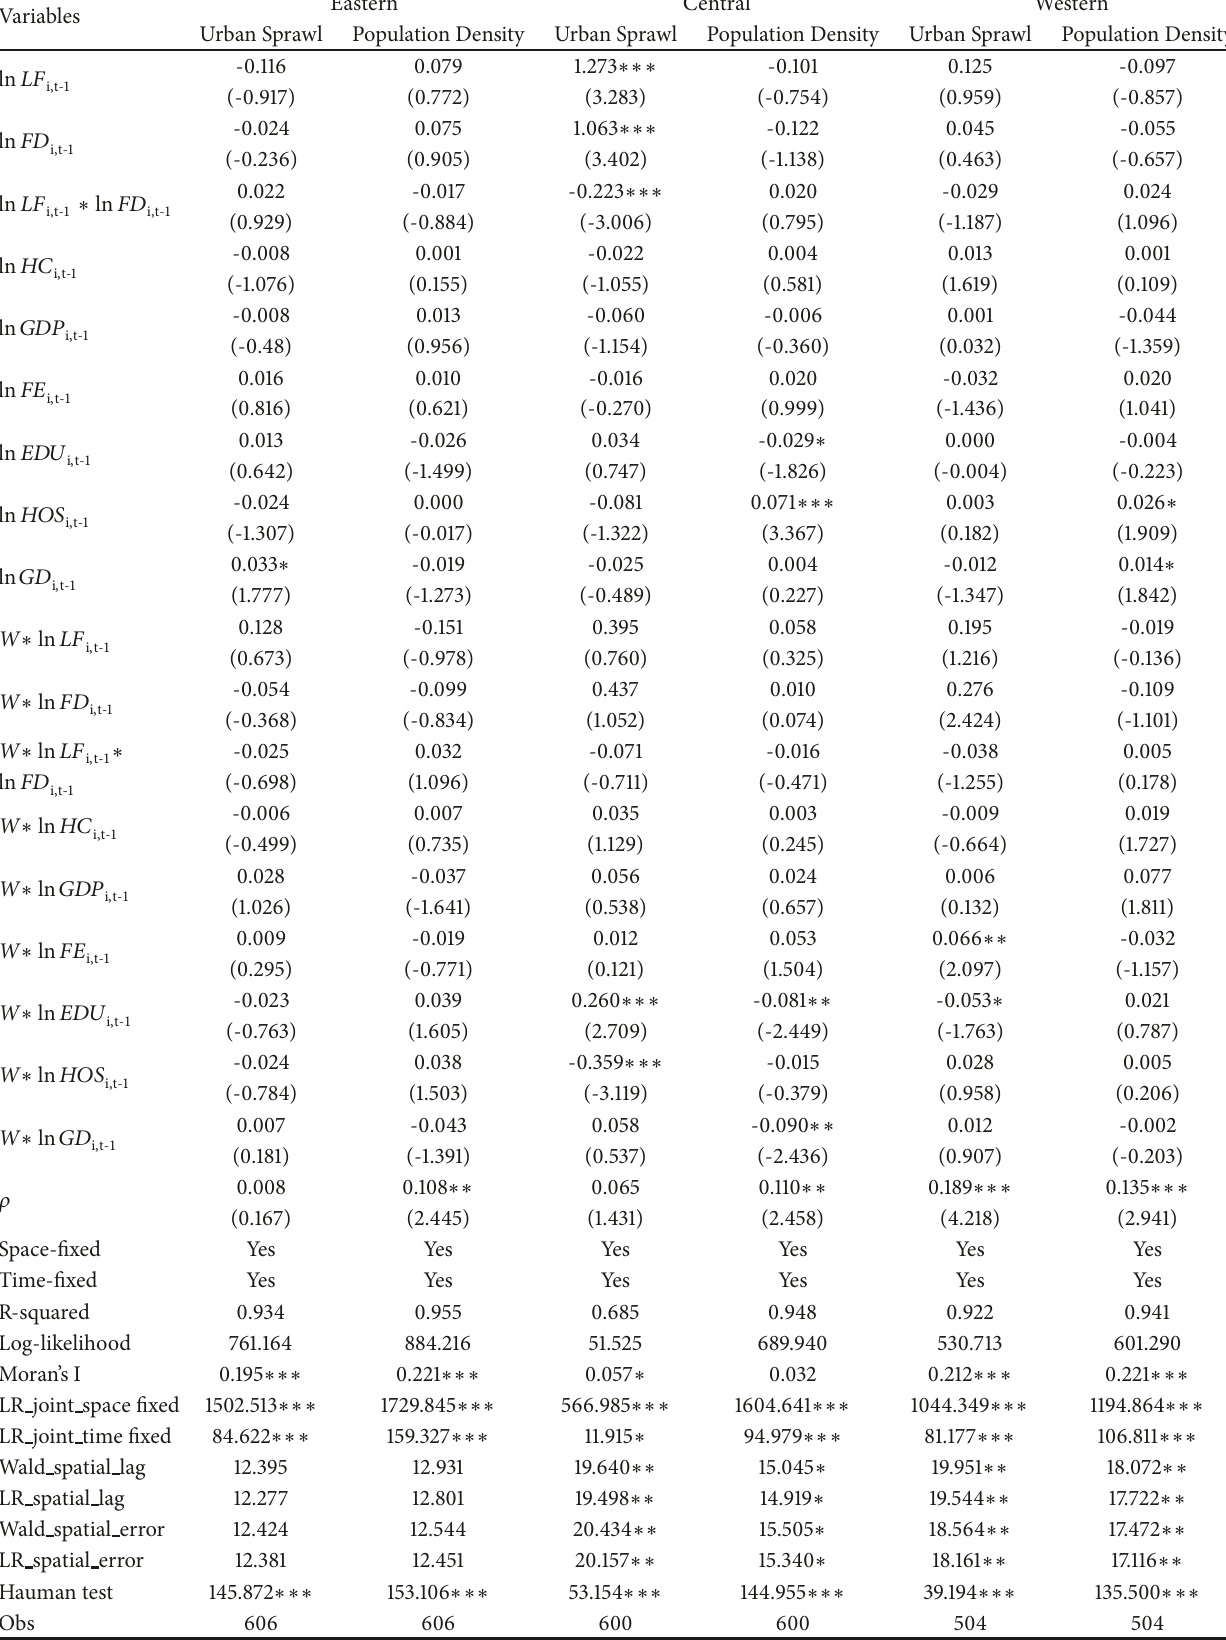
Table 5: The results of the subregional